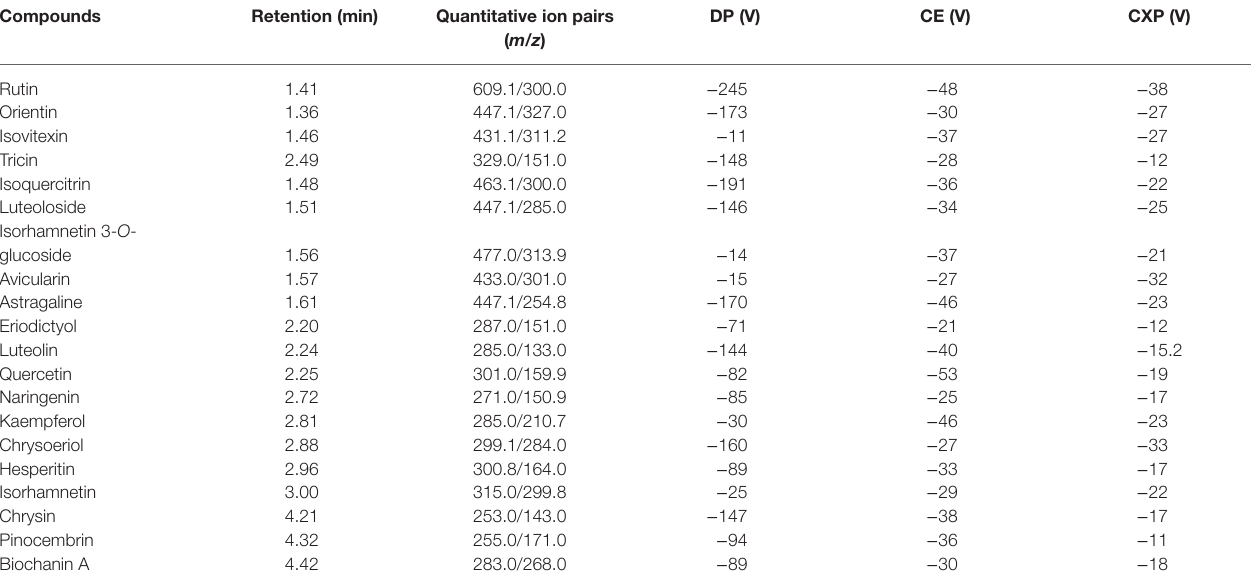
TABLE 2 | Mass spectra properties of flavonoids evaluated in A. squarrosum . Compounds